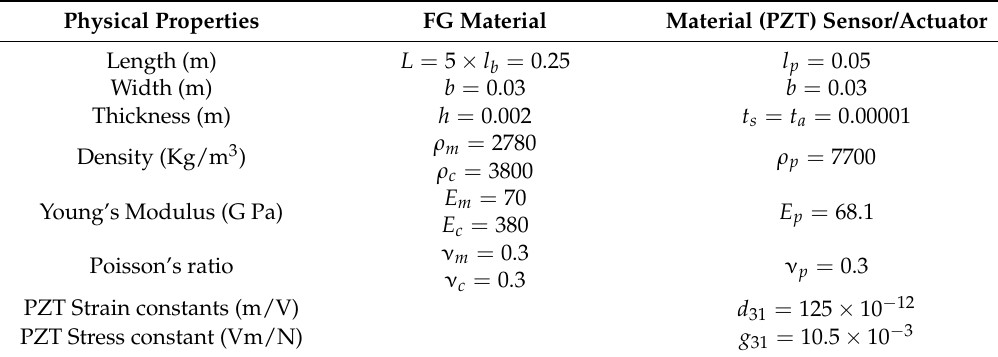
Table 1. Geometric and physical characteristics of the